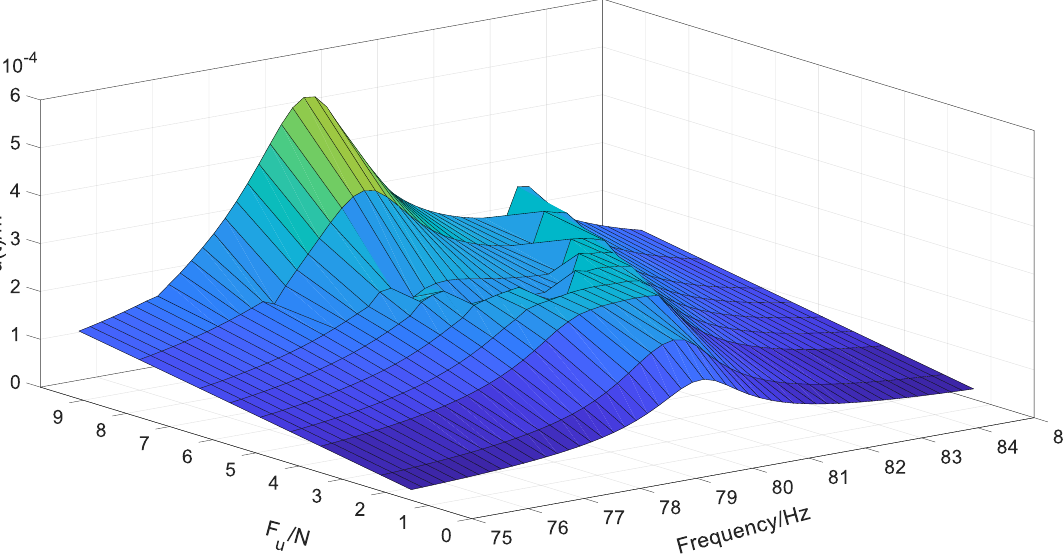
Figure 6. The periodic responses surface according to the excitation amplitude and the excitation frequency.